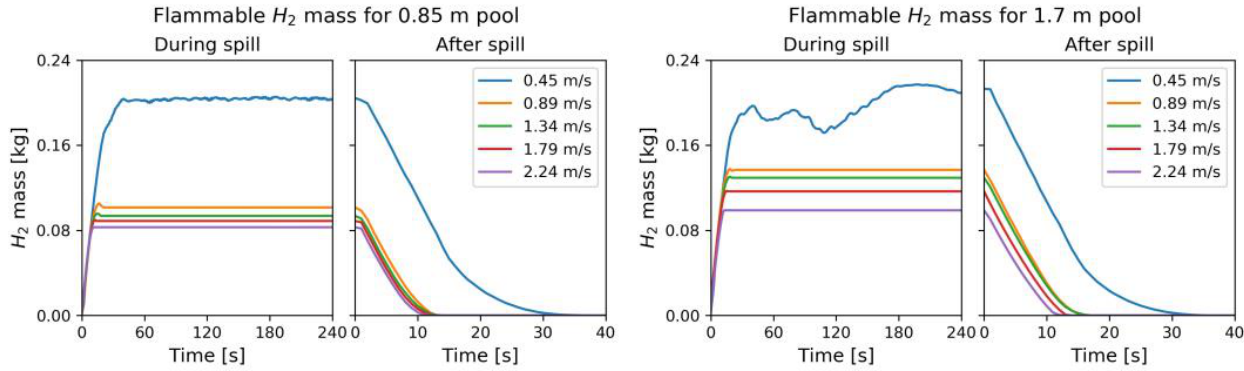
Figure 10. Evolution of flammable mass within for the two different pool diameters as a function of wind speed. For the second frame in each case, time 0 represents when the hydrogen inflow was set to 0.